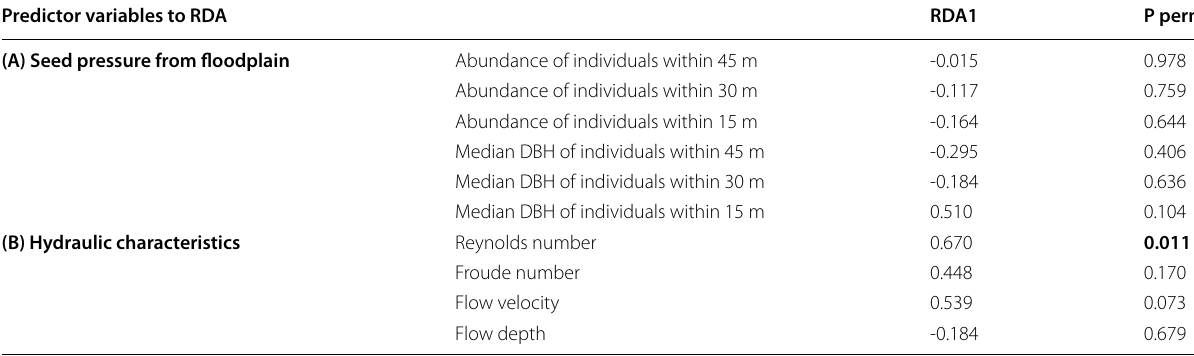
Table 1 Results of permutation analysis to relate through RDA the number of A. dealbata ´s seeds captured in the river with (A) presence of adult individuals of the same species at each site and (B) hydraulic characteristics at each sampled point. Significant results are highlighted in bold Predictor variables to RDA RDA1 P perm